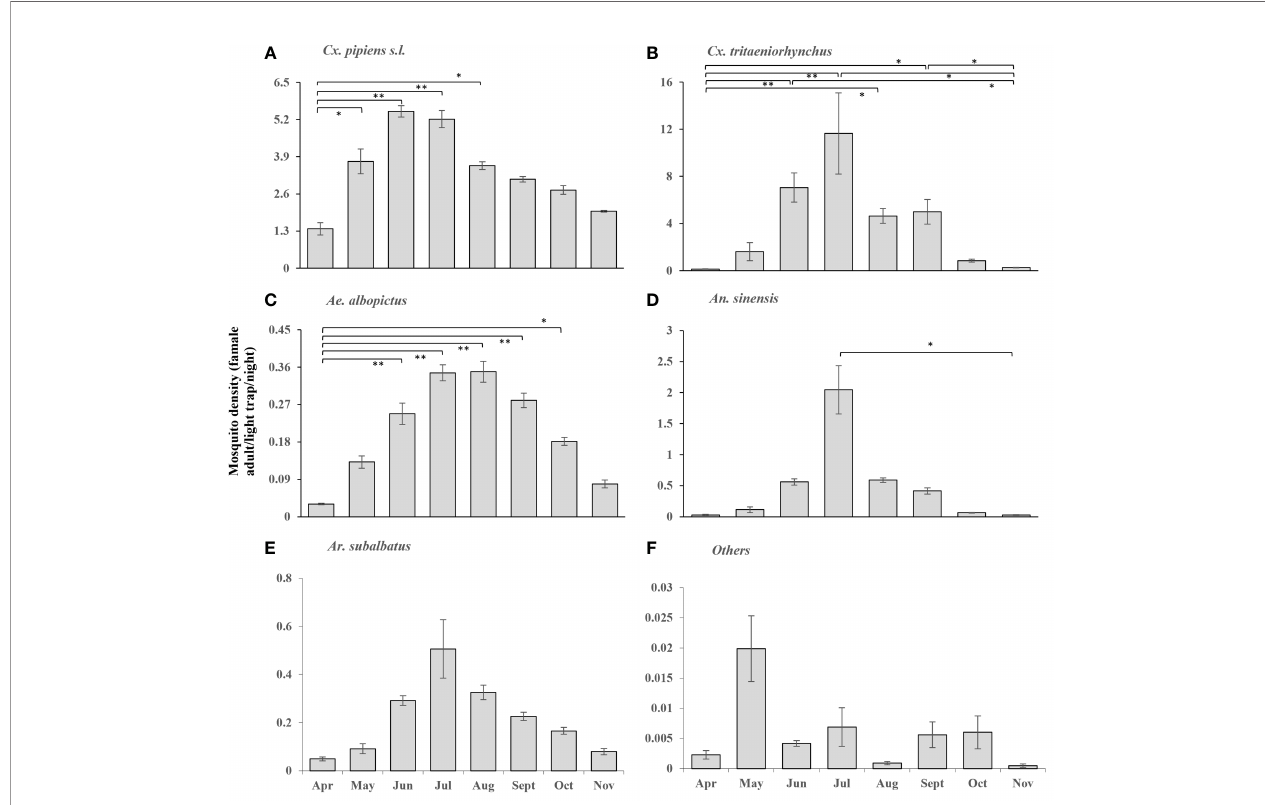
FIGURE 2 | According to the entomological investigation, the densities of female mosquitoes of different species of different habitats in Zhejiang Province from April to November, in 2018-2020. (A) Cx. pipiens s.l.; (B) Cx. tritaeniorhynchus; (C) Ae. albopictus; (D) An. sinensis; (E) Ar. subalbatus; (F) Others. Values are the mean ± standard error. Different patterns indicate signi fi cantly different (*: p<0.05; **: